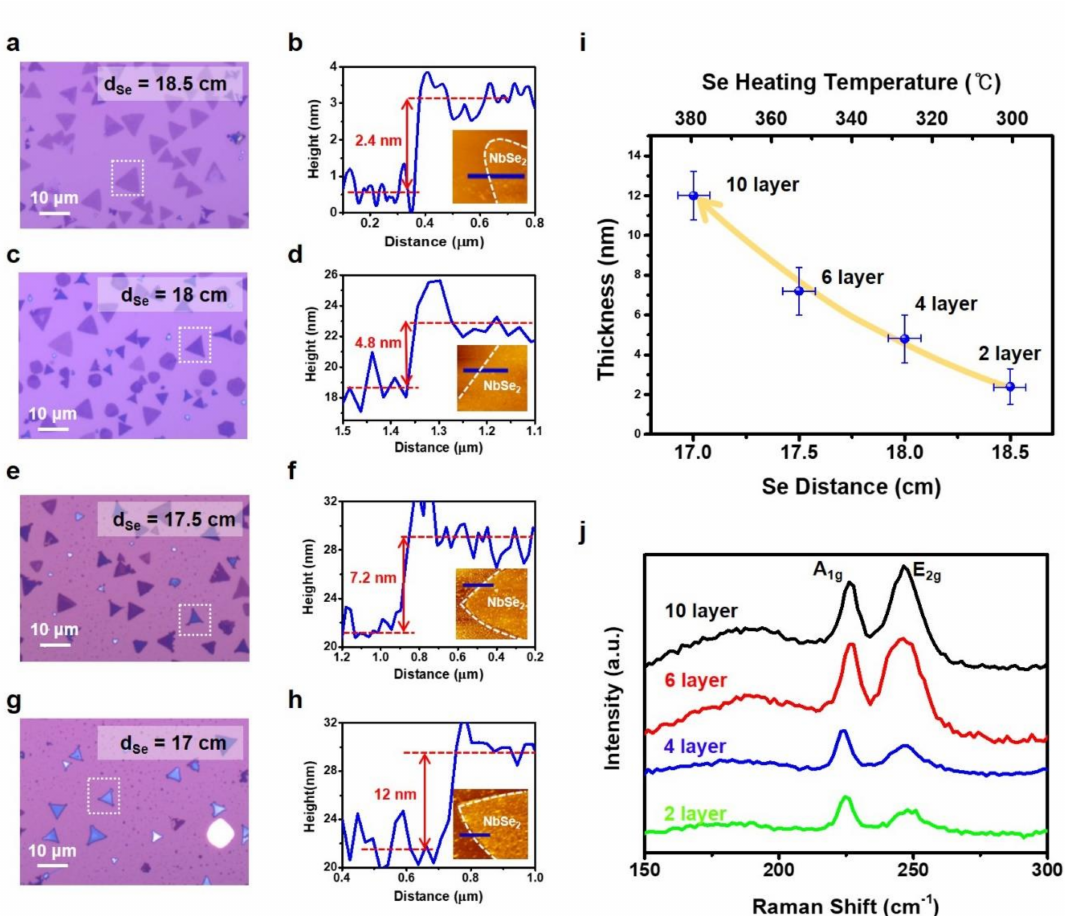
Figure 2. Different thickness of CVD-grown NbSe 2 via controlled growth parameter. ( a – h ) The microscope images, height profiles of 2 layer, 4 layer, 6 layer, and 10 layer NbSe 2 . The thickness of the flakes was controlled by the di ff erent distances to the Se from the center of the quartz; ( i ) the thickness tends to increase as the distance decreases, meaning that it increases the heating temperature of the Se source; ( j ) Raman spectrum according to the di ff erent thickness of the flakes under a 532-nm excitation wavelength